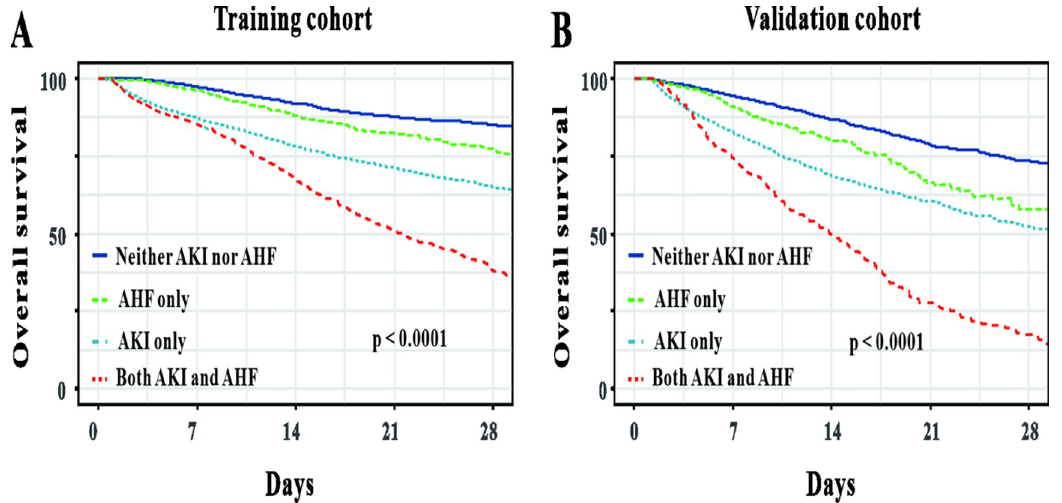
Fig 3. The Kaplan-Meier curves of overall survival for all patients stratified by the presence or absence of acute heart failure and acute kidney injury.